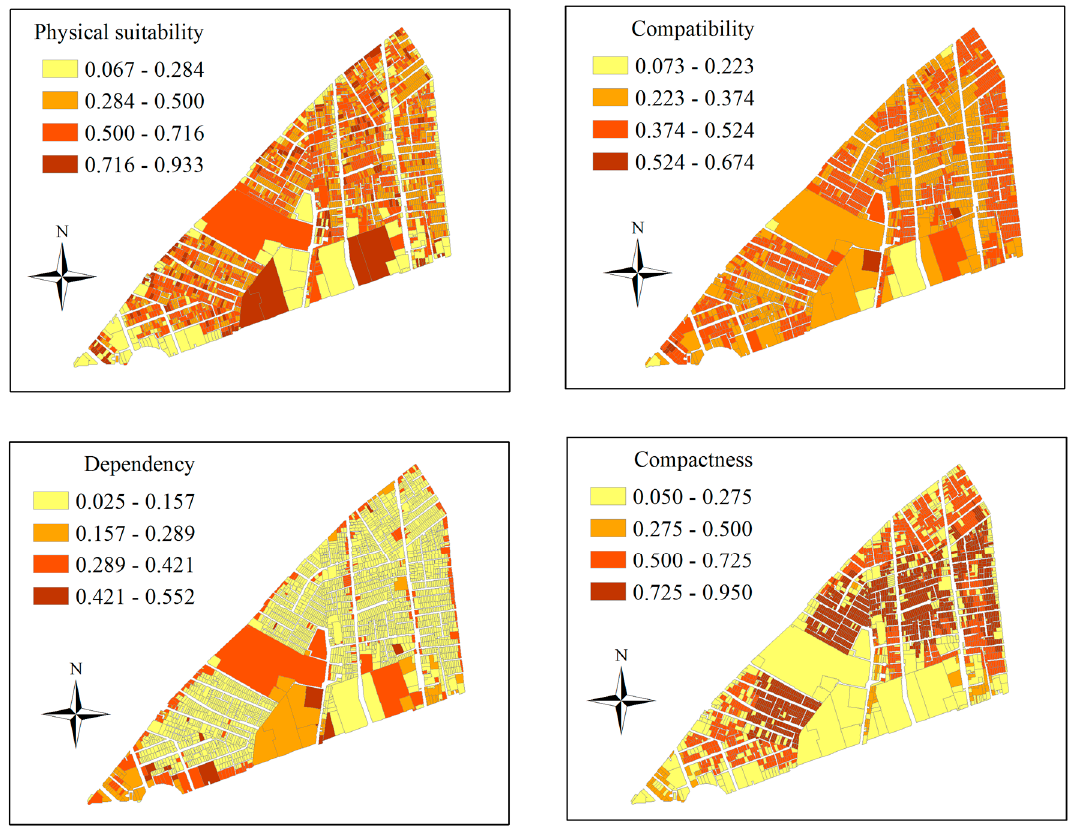
Figure 5. Defuzzified land-use evaluation criteria for current land-uses on the study area.